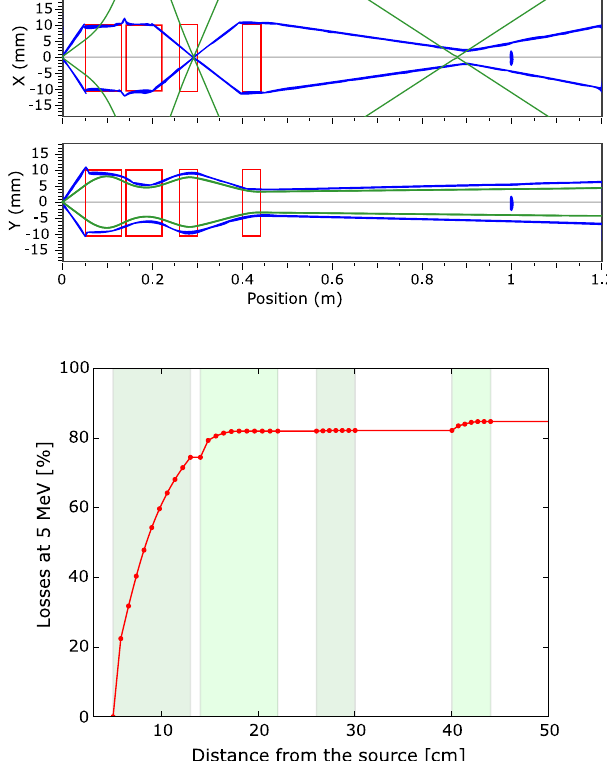
FIG. 3. 5 MeV proton beam simulations performed with the T race W in M ultiparticle tool in the described PMQ setup. The top pictures show the calculated envelope in the X and Y directions, with PMQs represented by the red rectangles, the actual beam envelope in blue, and the rms aperture-free beam envelope in green. The particle losses are plotted in the bottom graph, where the shaded area represents the